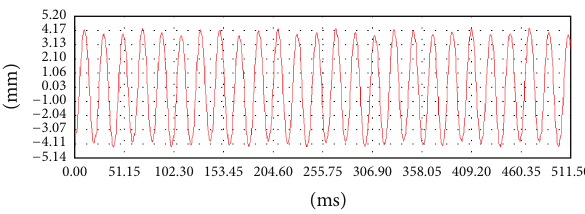
Figure 16: Wingtip’s dynamic response of an uncontrolled SMA composite wing when the mean wind velocity 𝑉 = 8m/s.